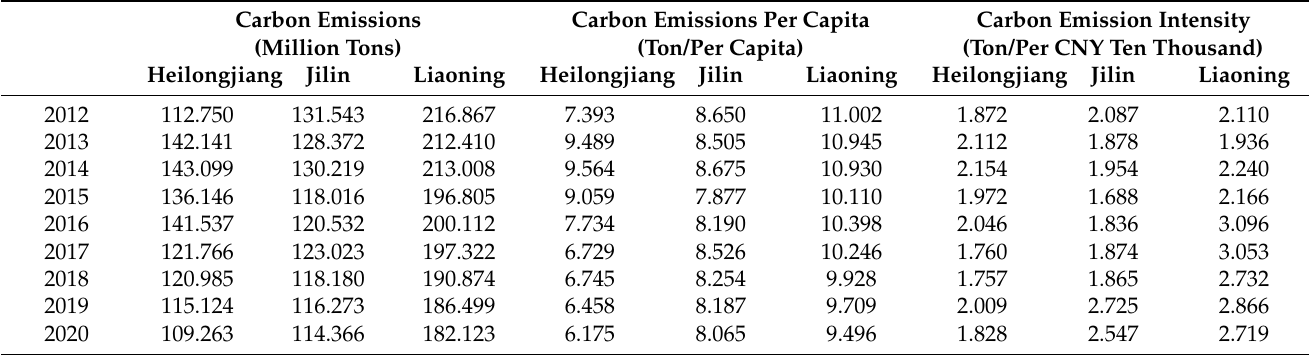
Table 4. Natural emissions, carbon emissions per capita, and carbon emission intensity by province over time